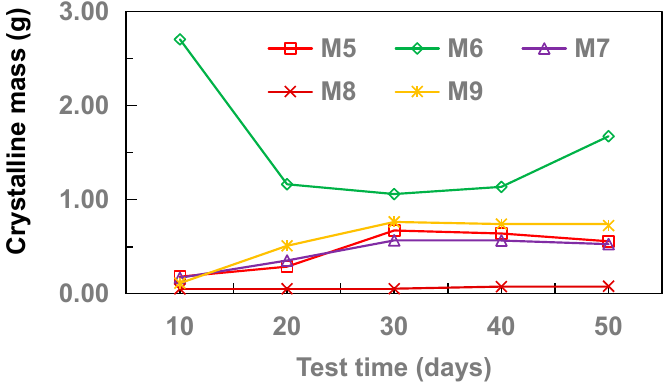
Figure 11. Variation of crystal quality with time.